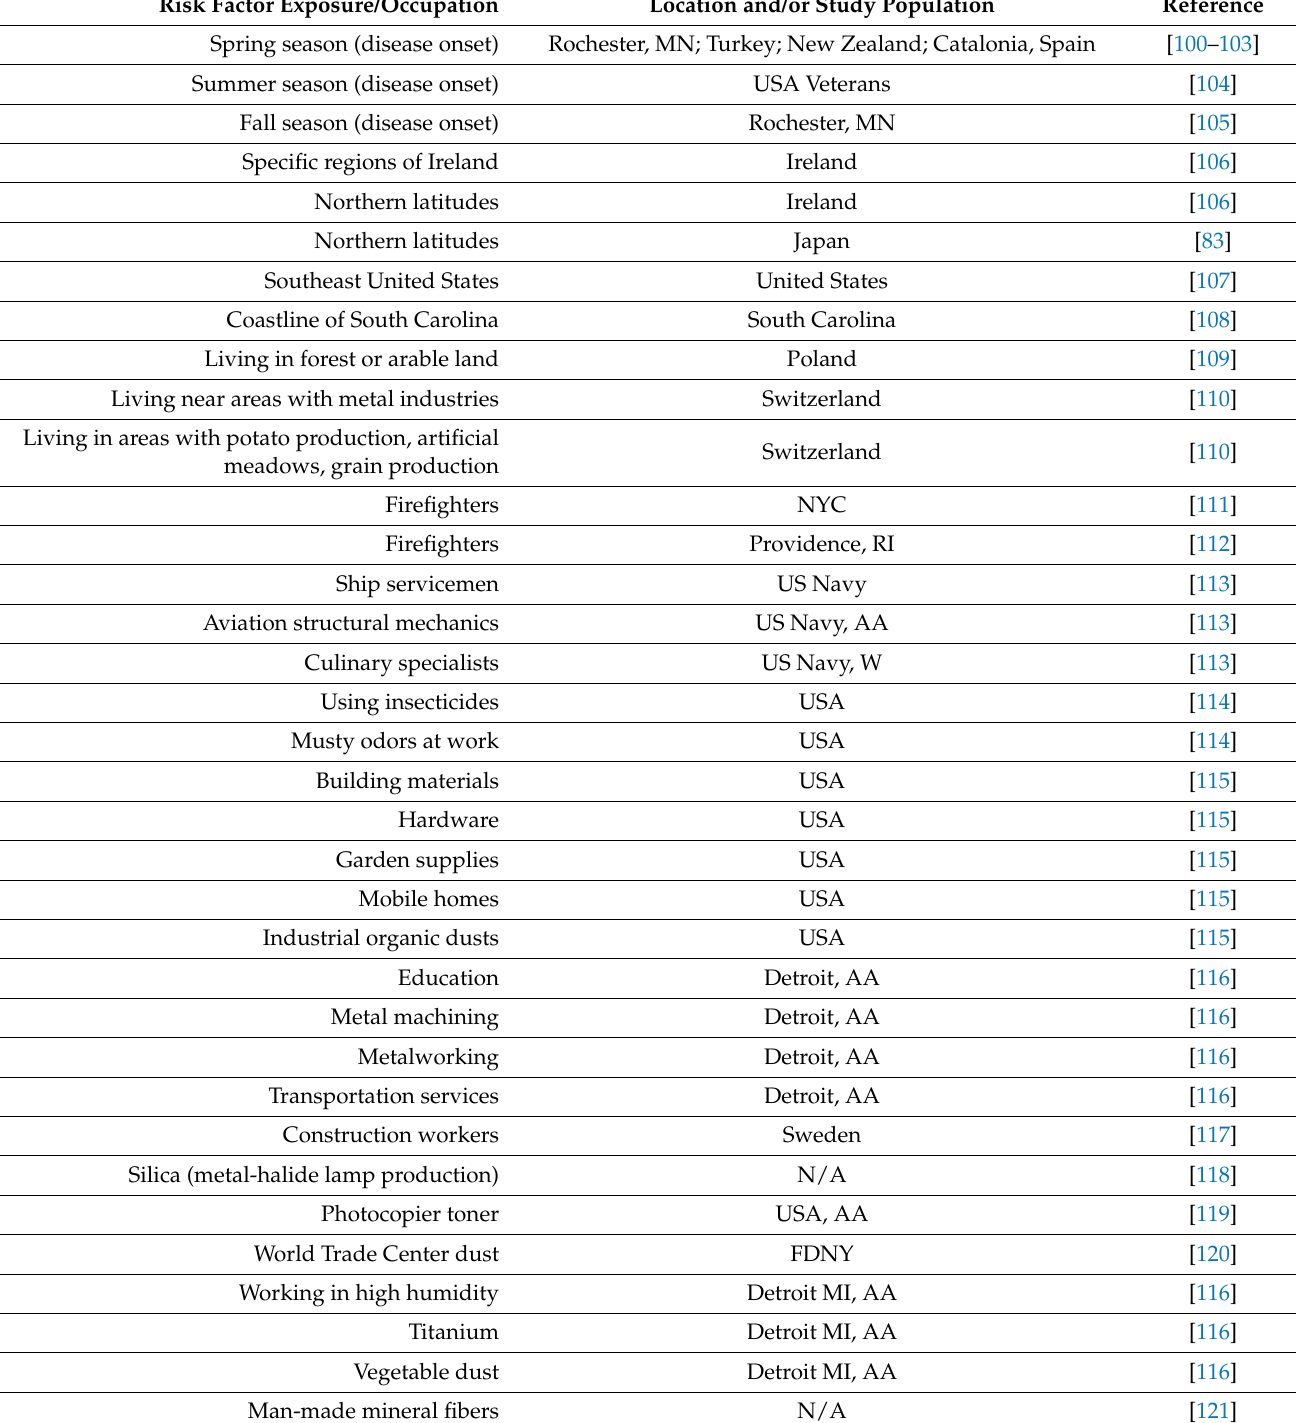
sarcoidosis patients, sarcoidosis patients who were exposed to putative etiologic agents had a significantly increased mortality odds ratio than non-sarcoidosis patients without similar exposures [99]. There were significant differences in exposure-associated mortality by sex and race. These data suggest that there may be an interaction between exposure, demographics, and mortality in sarcoidosis. Table 3. Environmental and occupational risk factors and protective factors for sarcoidosis. Risk Factor